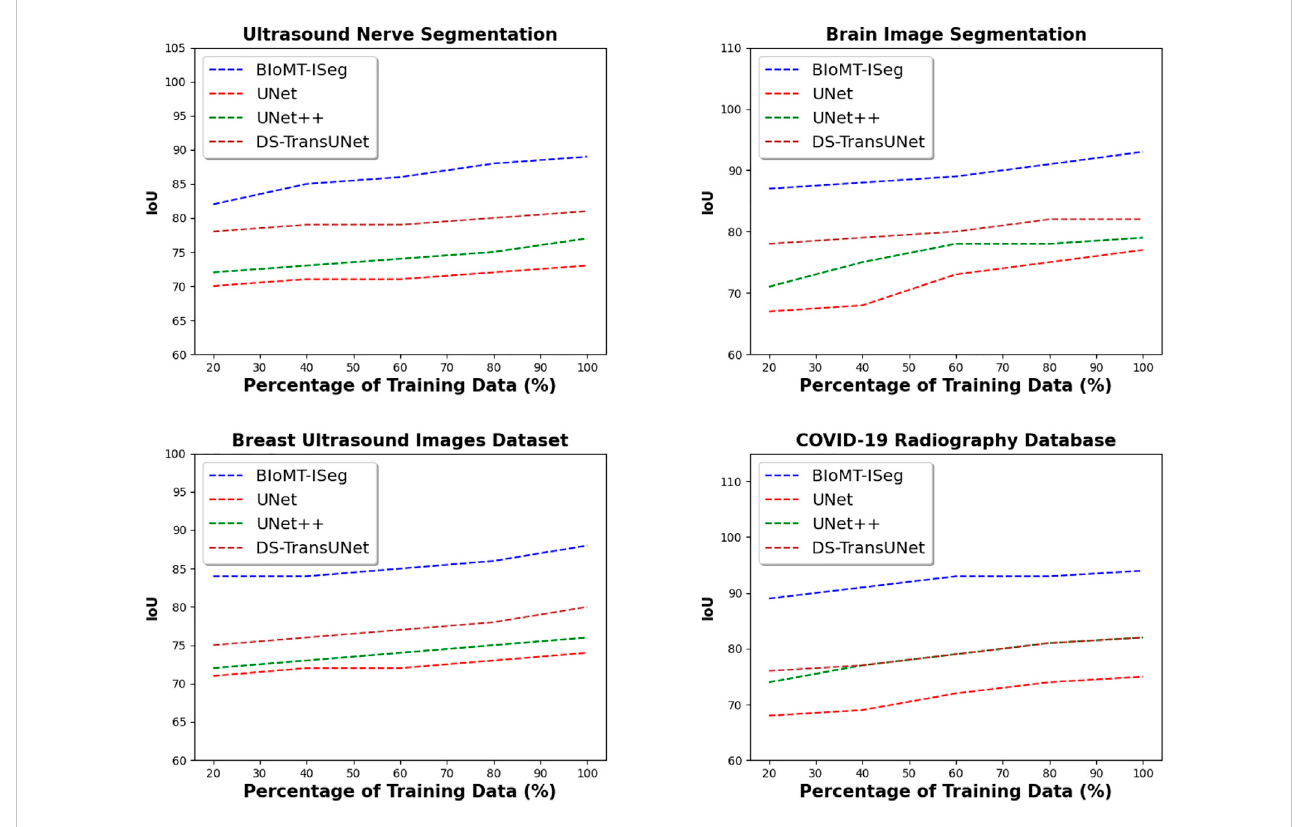
FIGURE 7 IoU of the proposed framework, and the baseline models using medical image